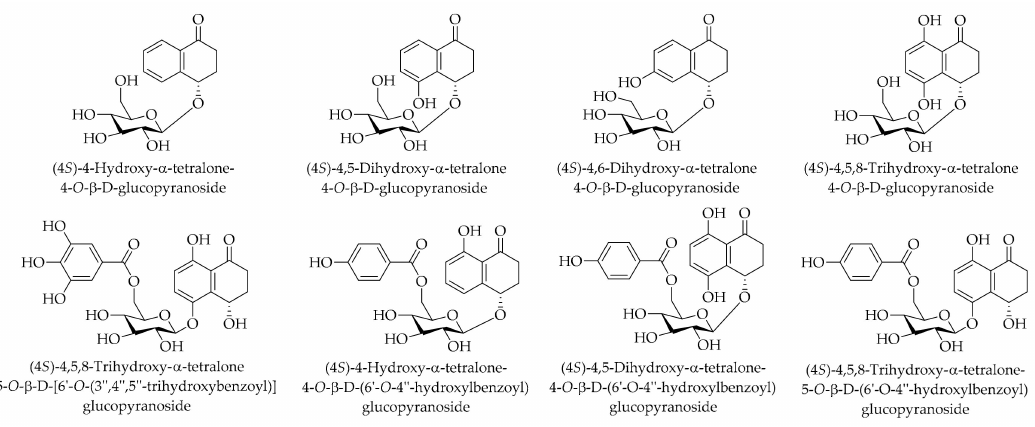
Figure 7. The chemical structures of di ff erent identified, isolated, and quantified α -tetralone glycosides in the walnut green